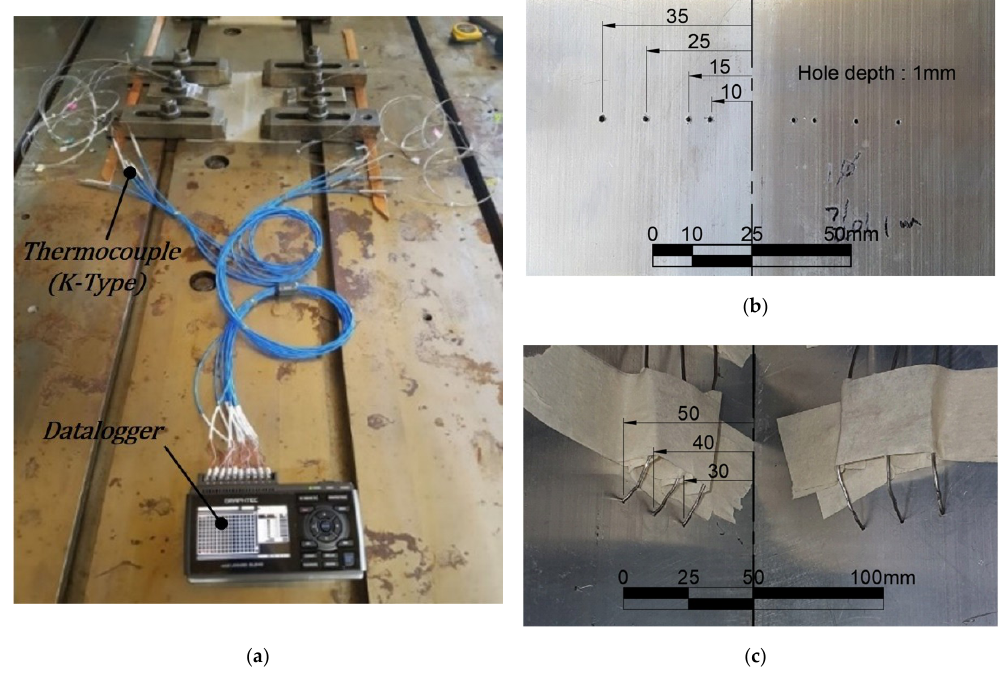
Figure 9. Experiment of temperature measurement: ( a ) Measuring equipment; ( b ) measuring point of butt FSW; ( c ) measuring point of fillet FSW.